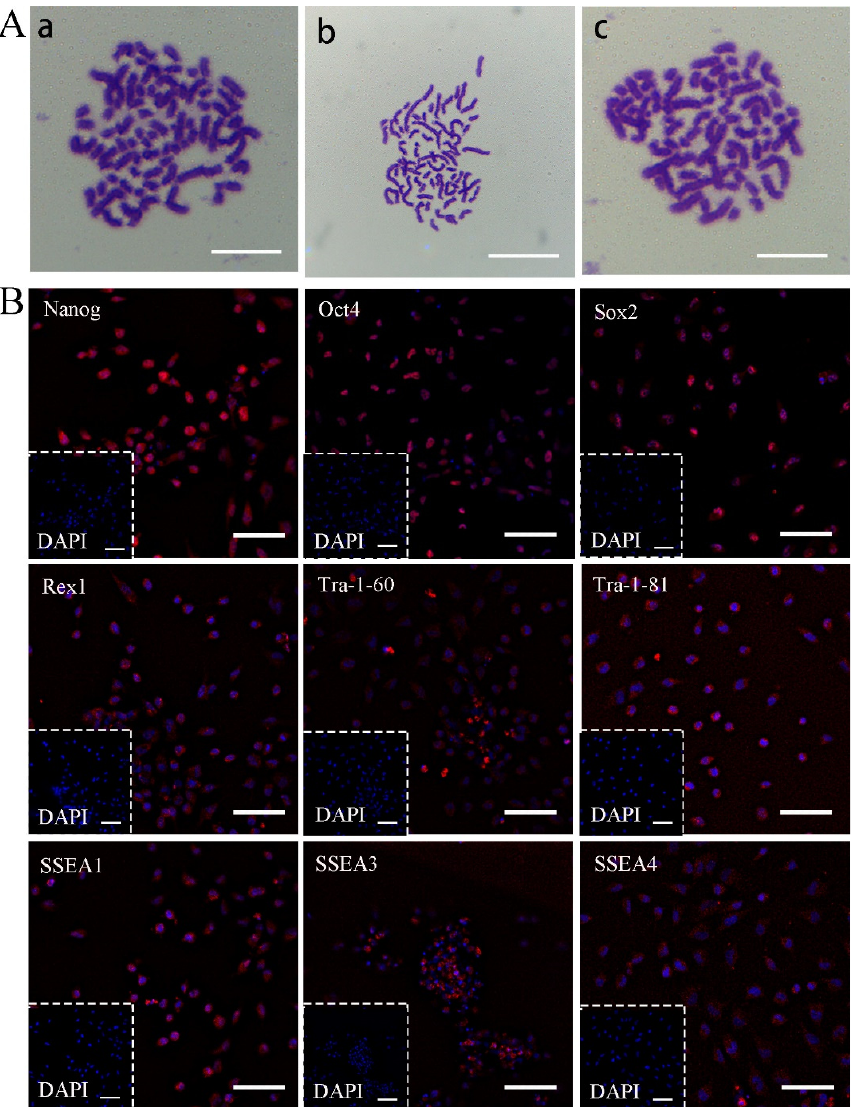
Figure 2. The epigenetic features and pluripotency of bciPSCs. ( A ) The karyotype of a , bciPSC-A2, b , bciPSC-A3, and c , bciPSC-B13 were 74 (100 × , 10 µ m); ( B ) Immunofluorescence identification of P11 bciPSC-A3. Nanog, Sox2, Oct4, SSEA1, SSEA3, SSEA4, Rex1, Tra-1-60, and Tra-1-81 were all positive (20×, 50 μ m).